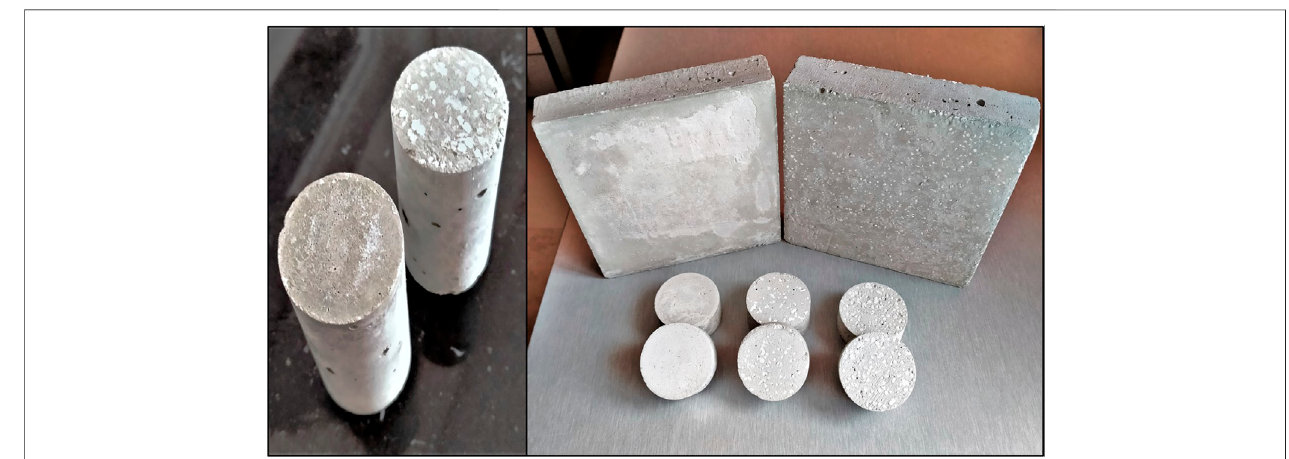
FIGURE 1 | Cement-Expanded-Polystyrene (CEP)